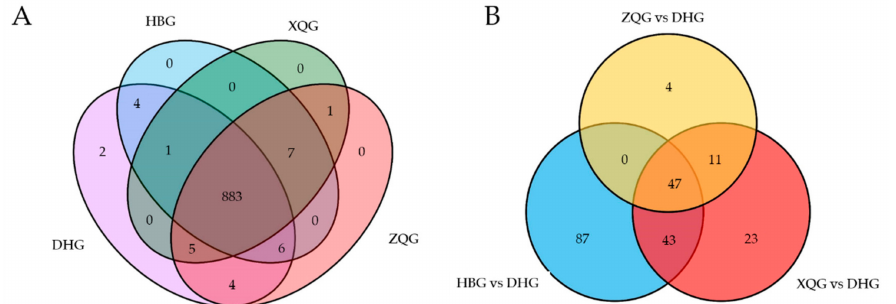
Figure 3. Venn diagrams of metabolites detected for each group ( A ) and di ff erential metabolites for three comparison groups ( B